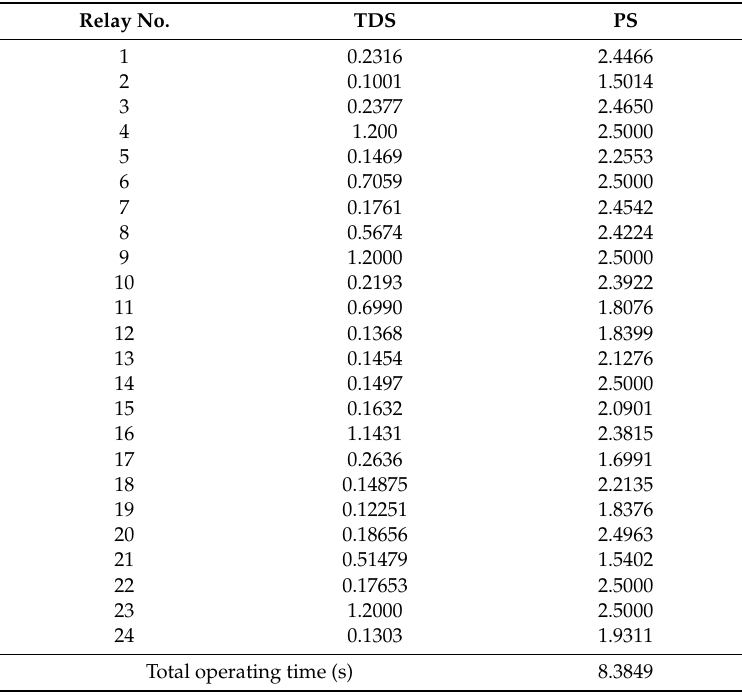
Table 9. Optimal TDS for the IEEE nine-bus system.